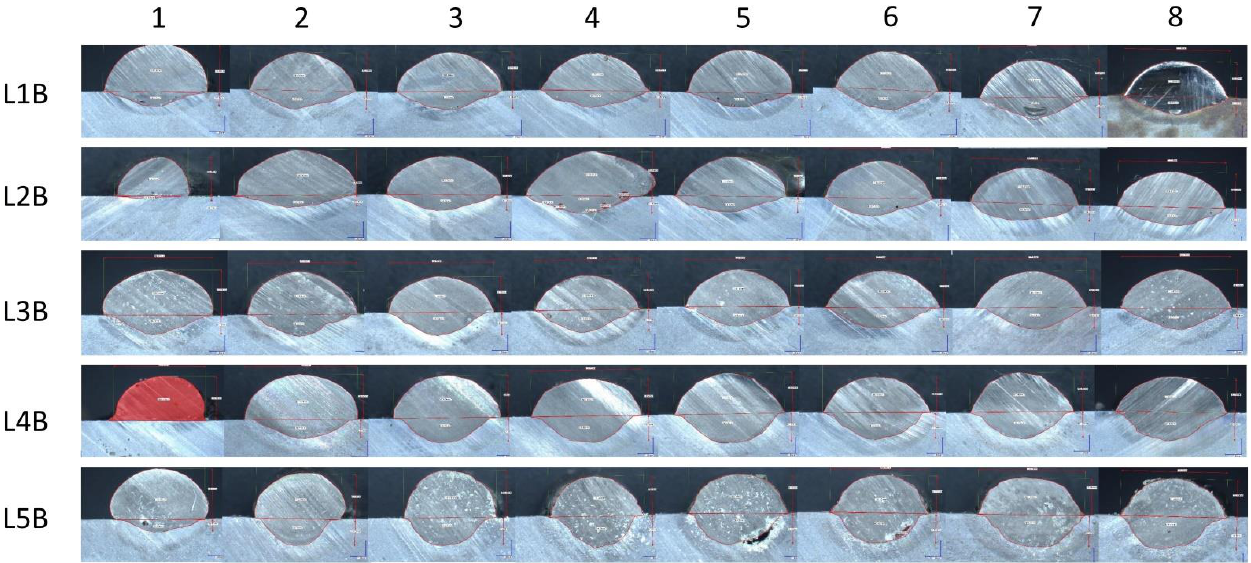
Figure 9. Graph representing the dependence of the weld bead height and penetration (marked as “depth”) on the heat input level. The red and blue dashed lines express the second order interpo- lation, while the green dashed line marks the assumed, target value for the reference.